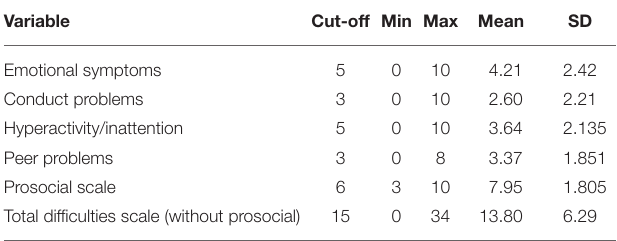
TABLE 1 | Socio-demographic data of the respondents. TABLE 2 | Emotional and behavioral problems in young refugee